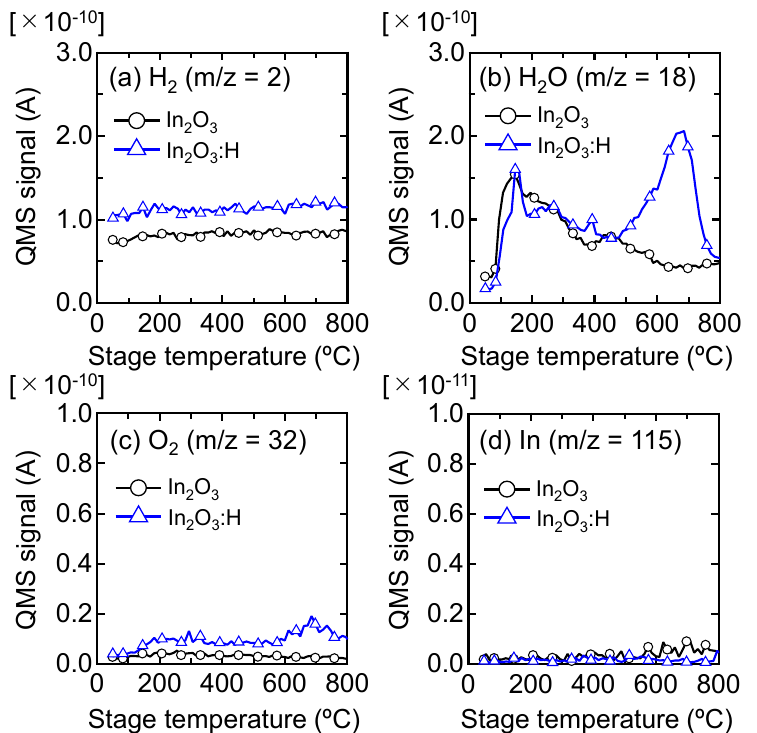
Figure 5. ( a ) H 2 , ( b ) H 2 O, ( c ) O 2 , and ( d ) In desorption spectra from as-deposited In 2 O 3 and In 2 O 3 :H films.